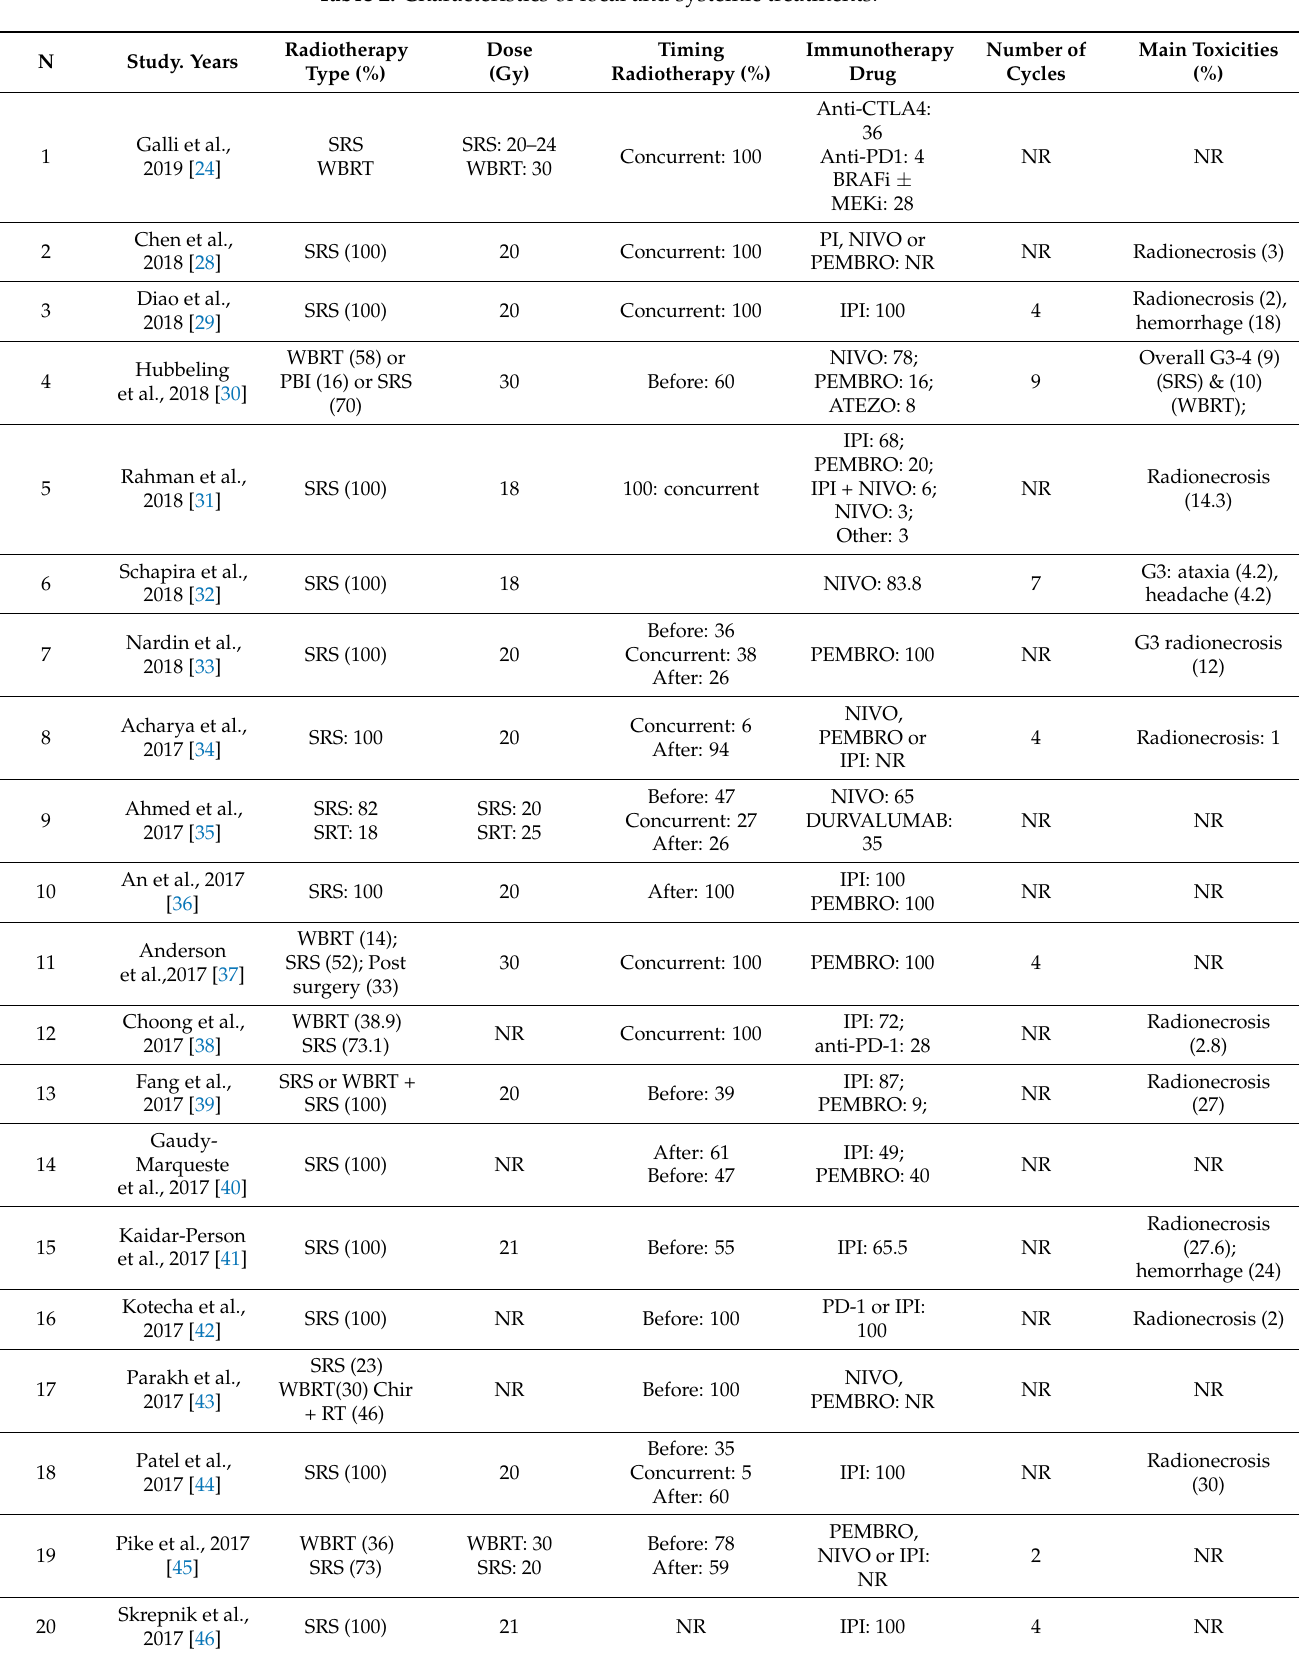
Table 2. Characteristics of local and systemic